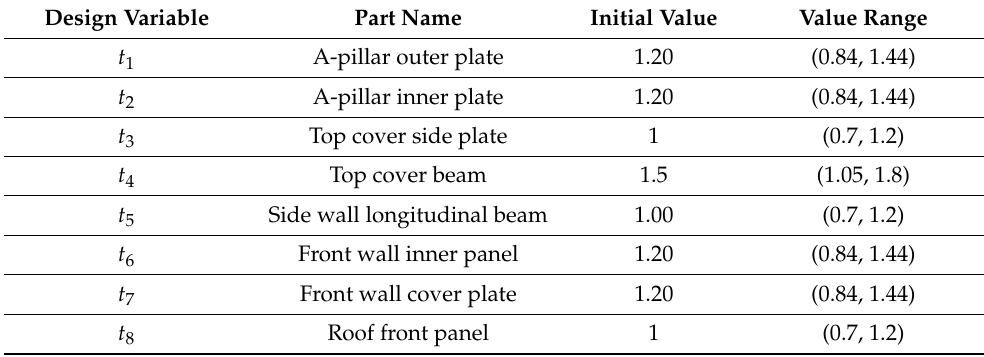
Table 1. Key design variables and value range.